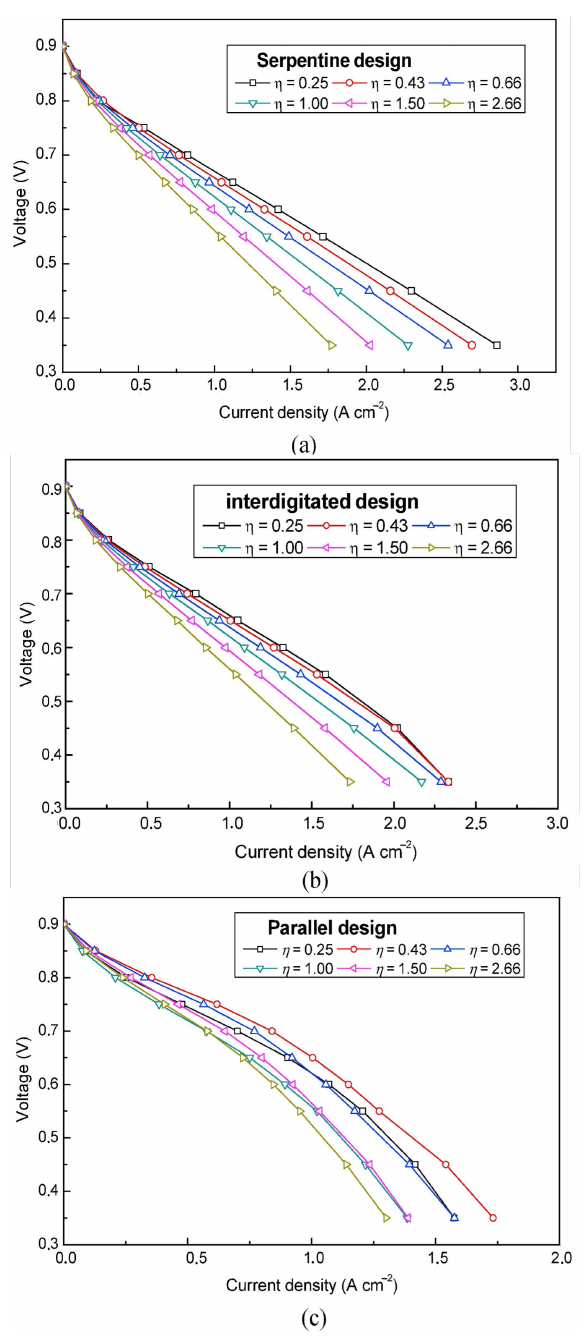
Figure 5. The polarization curve of PEMFC with different channel-to-rib width ratio in: ( a ) parallel; ( b ) serpentine; and ( c ) interdigitated flow field